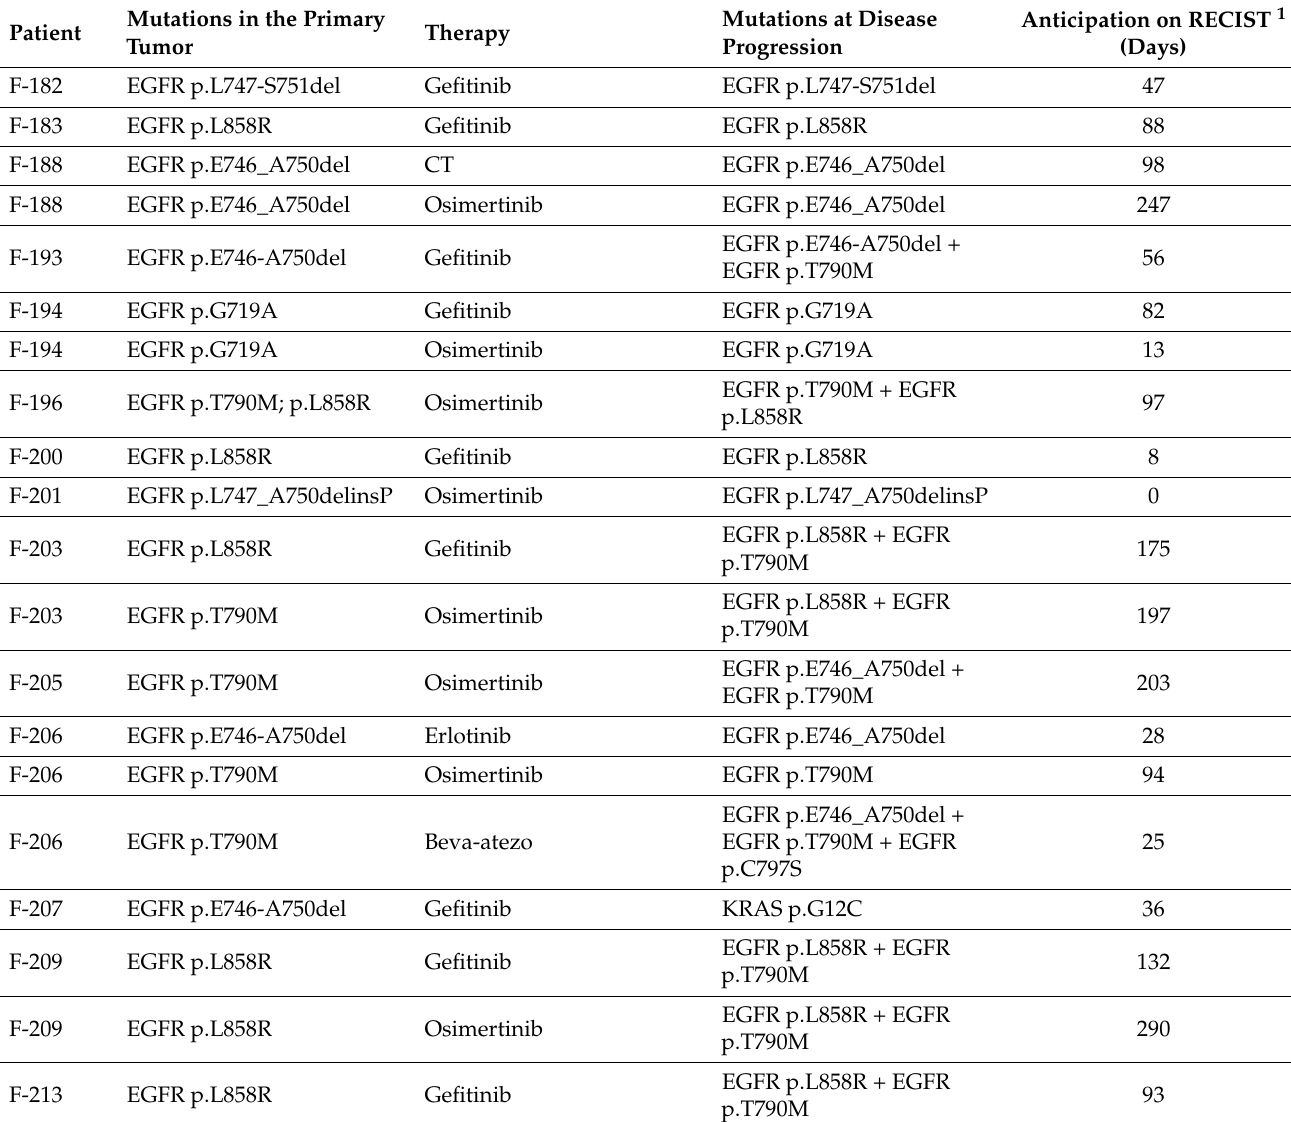
Table 3. Mutations at patients’ progression detected by liquid